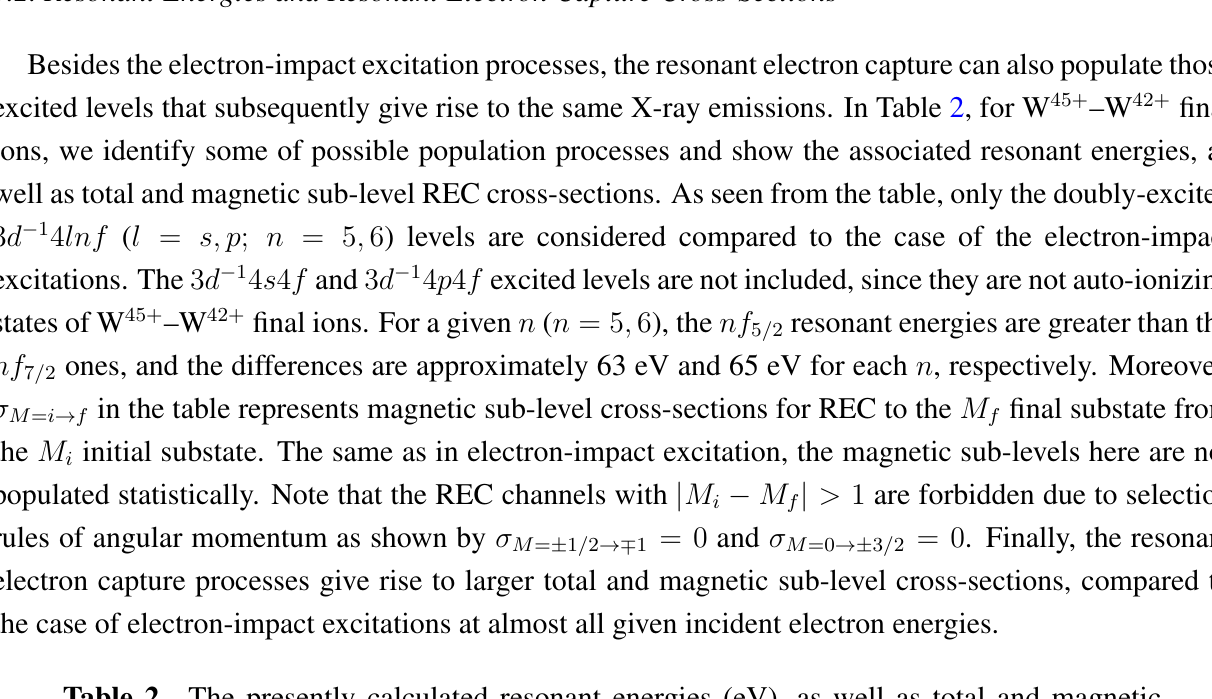
Table 2. The presently calculated resonant energies (eV), as well as total and magnetic sub-level cross-sections ( 10 − 20 cm 2 ) for resonant nf ( n = 5 , 6 ) electron captures of final W 45+ –W 42+ ions. Note that closed inner-subshells have been omitted from the initial and final levels for the sake of